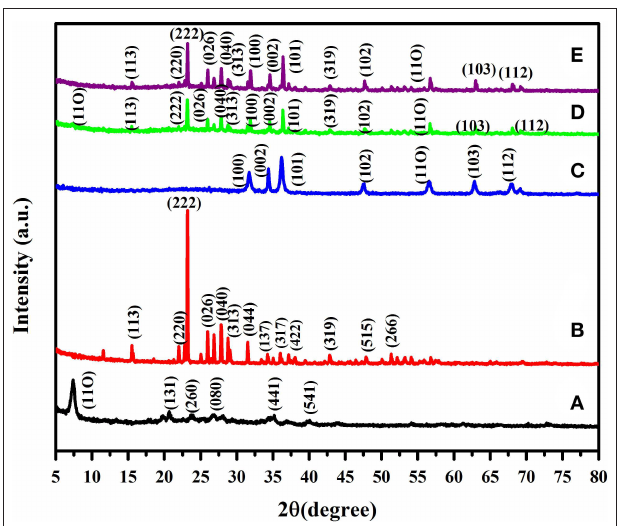
FIGURE 2 | XRD pattern of (A) SSp (seived sepiolite), (B) PS (sublimed sulfur), (C) ZnO (Zinc oxide nanoparticles), (D) S/SvSp/ZnO (sulfur/seived sepiolite/Zinc oxide), and (E) S/PTSp/ZnO (sulfur/post-treated seived sepiolite/Zinc oxide).